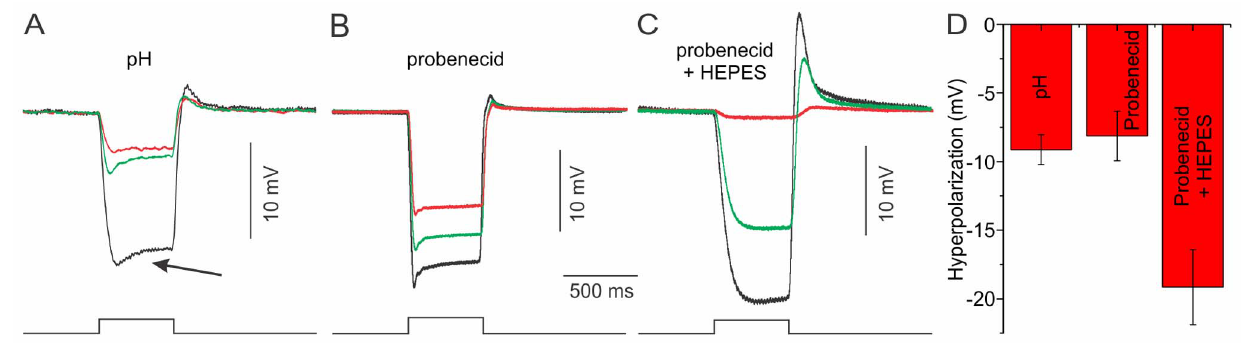
Figure 5. HC responses in various pharmacological conditions. (A) Acidification of the extrasynaptic medium reduces the rollback response in goldfish HCs (arrow) ( n =4) and hyperpolarizes the HC membrane potential (see D) (black, control; red, pH 7.2; green, wash). This indicates that the slow component of feedback contributes to the rollback response in HCs. (B) Application of probenecid also led to a slight reduction of the rollback response ( n =18) and hyperpolarization of the HC membrane potential (see D). The rollback response never disappeared completely (black, control; red, probenecid; green, wash). (C) Application of probenecid in a Ringer’s solution containing 28 mM HEPES. In this condition, the HC light responses were almost completely blocked and HC hyperpolarized strongly [see D; black, HEPES; red, HEPES + probenecid; green, HEPES (wash)]. (D) Mean 6 sem